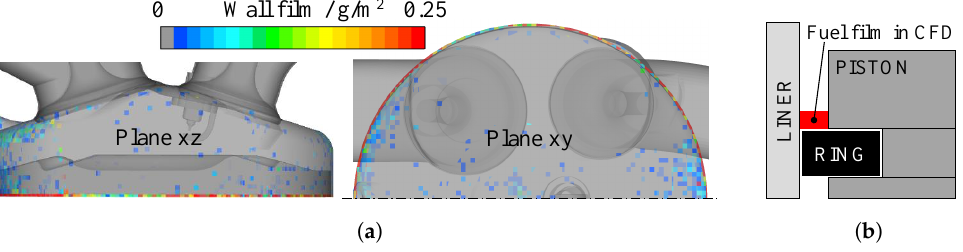
Figure 2. Fuel-film distribution in the combustion for the OP HP at 20 ◦ CA before TDC F . ( a ) CFD rusults of the fuel-film formation on different planes, ( b ) schematization of the film positioning in the piston top-land crevice